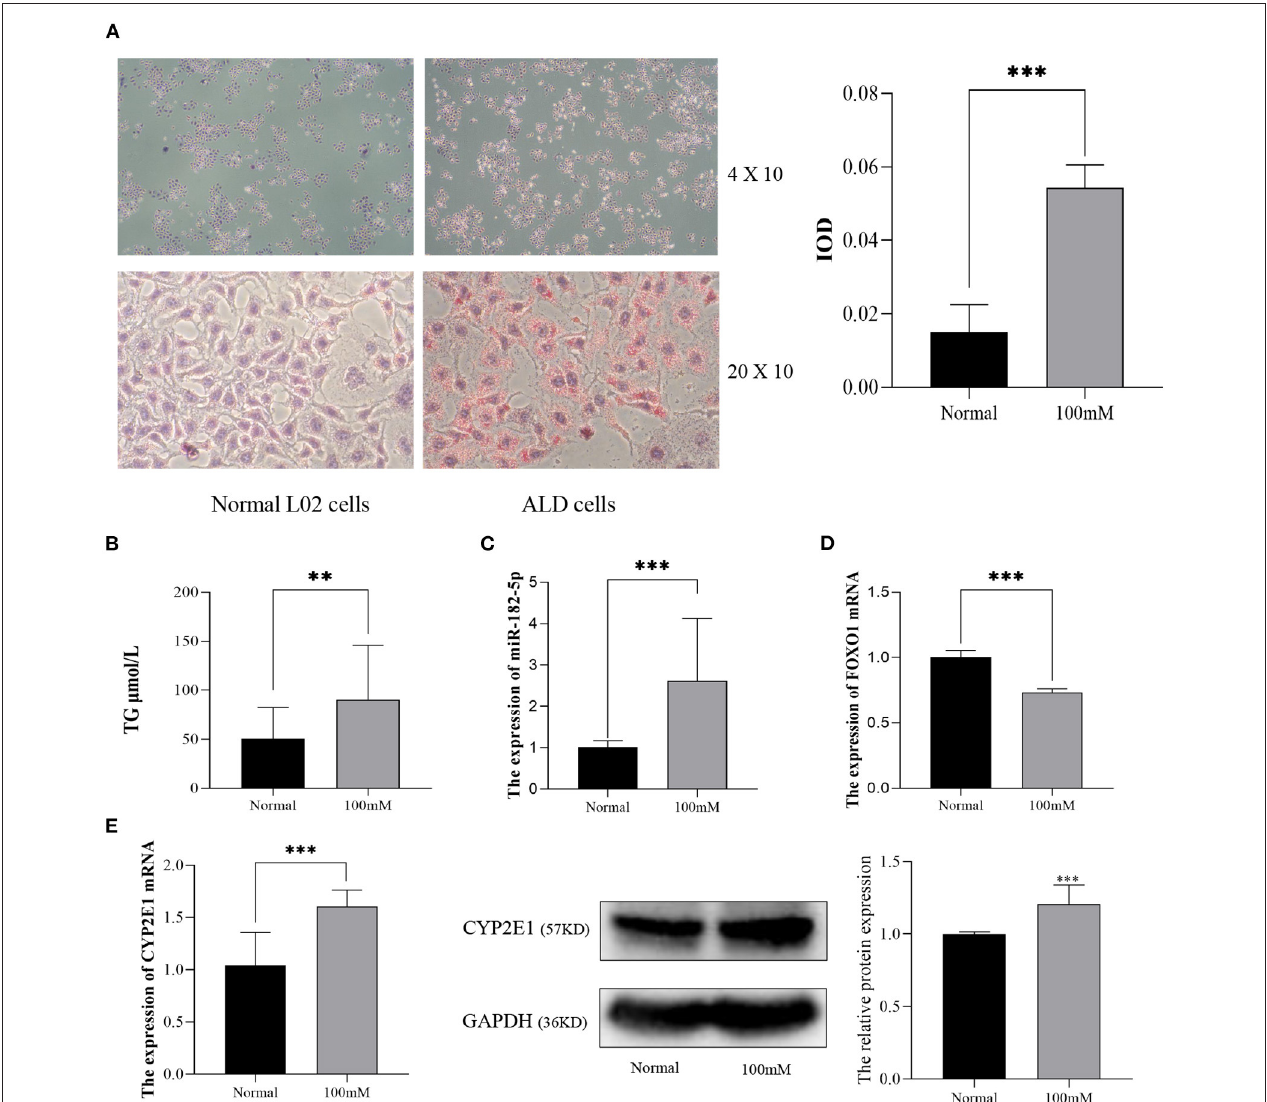
FIGURE 5 | Validation of the expression of miR-182-5p and FOXO1 in an ALD cell model. (A) Oil Red O staining ( × 40 and × 200) and IOD analysis of L02 cells with 100mM alcohol, (B) difference in TG levels between ALD and L02 cells, (C,D) expression of miR-182-5p and FOXO1 mRNA, (E) expression of CYP2E1 between ALD and L02 cells. ALD, alcoholic liver disease; TG, triglycerides; IOD, integrated optical density. ** p < 0.01, *** p < 0.001.